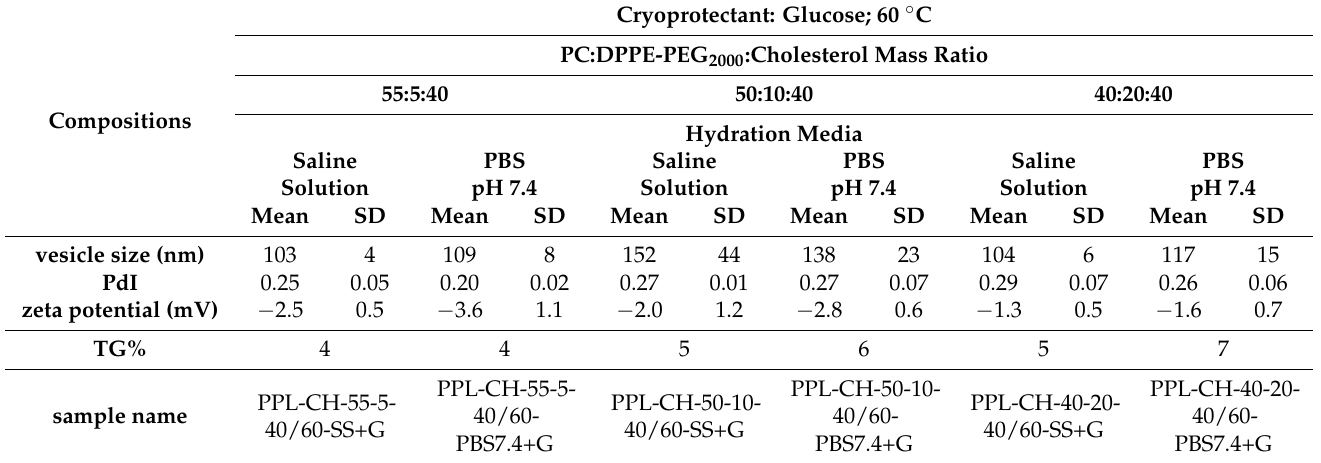
Table 9. Measurement results of the liposome samples prepared from different phosphatidylcholine (PC), PEGylated phosphatidylethanolamine (DPPE-PEG 2000 ) and cholesterol (CH) ratios at 60 ◦ C, hydrated with saline solution or PBS pH 7.4 and lyophilised with glucose as